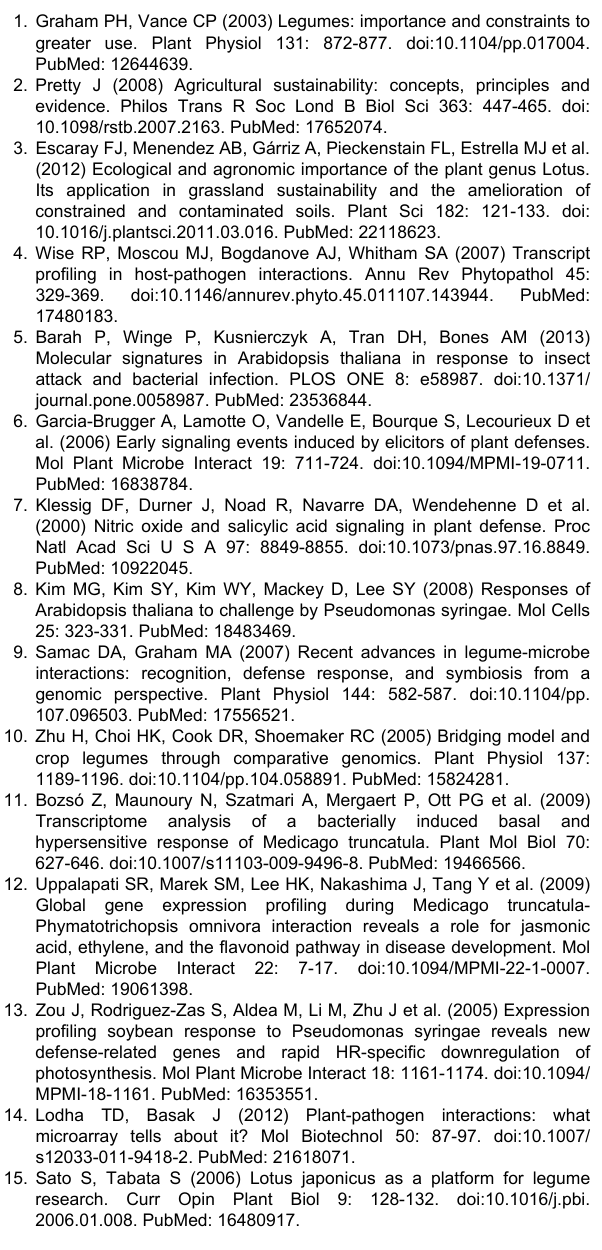
Table S3. Microarray and qRT-PCR expression values for genes used to build Figure